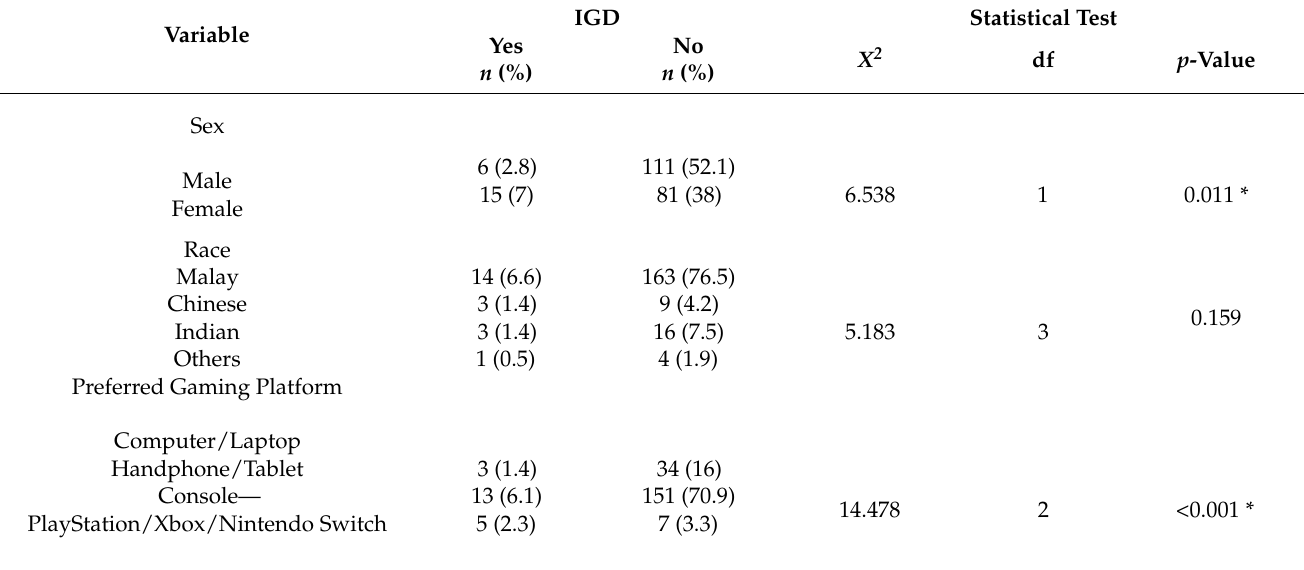
Table 2. Association between sociodemographic profile, gaming elements, history of substance use, depression, anxiety, and stress with IGD ( n =